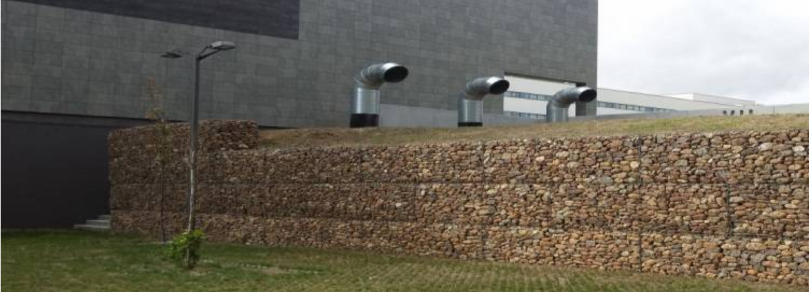
Figure 6. Geothermal system (Canadian